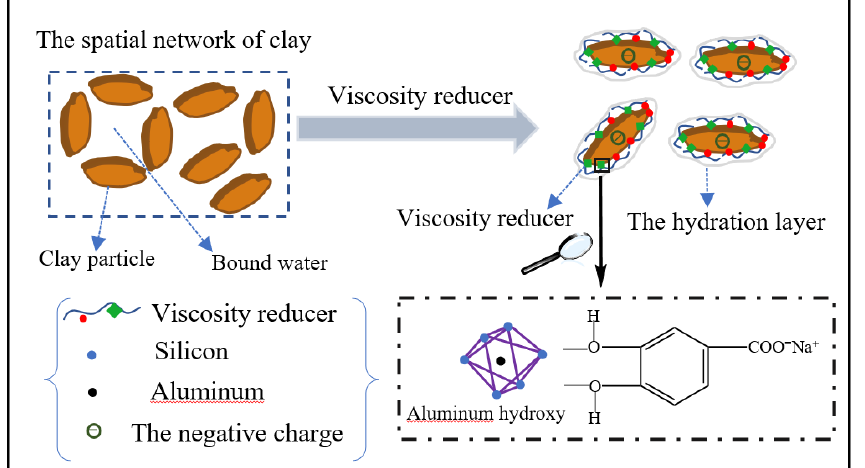
Figure 10. Analysis of the viscosity reduction mechanism of VR-H.